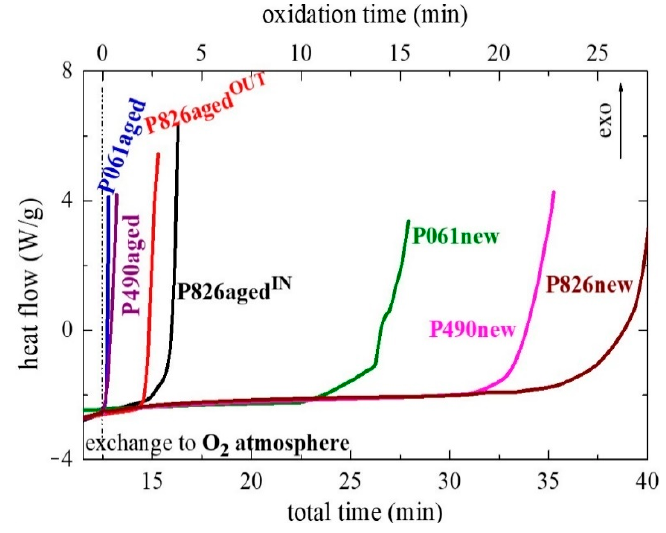
Figure 8. Thermo-oxidative response at a temperature of 210 °C for the different pipes. The oxidation stage begins at 12.5 min of total time.